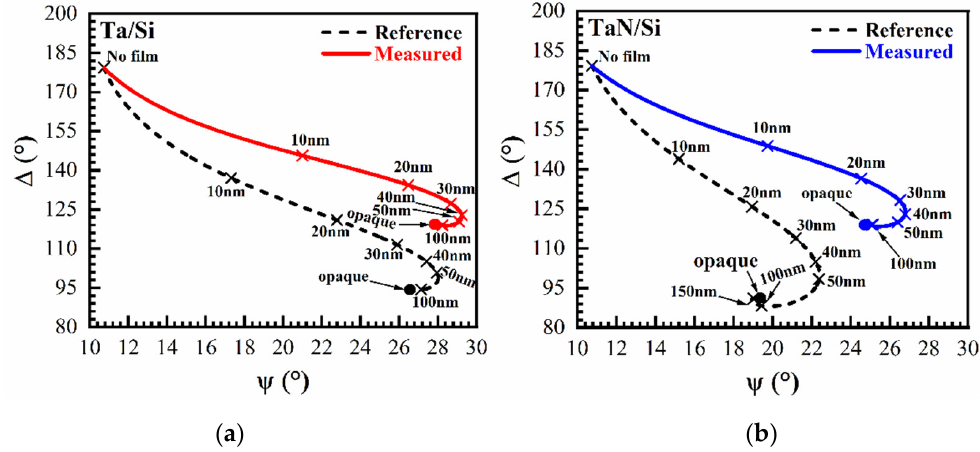
Figure 10. Optical characteristics (the calculated Δ – Ψ trajectories) of deposited ( a ) Ta and ( b ) TaN films with different thicknesses. The solid curves were calculated by using optical characteristics at 633 nm measured in our films deposited with 12 sccm N 2 . The dashed curves are based on optical characteristics reported in Ref. [27] (633 nm, Ar to N 2 ratio = 4:1, the flow rate is not reported).